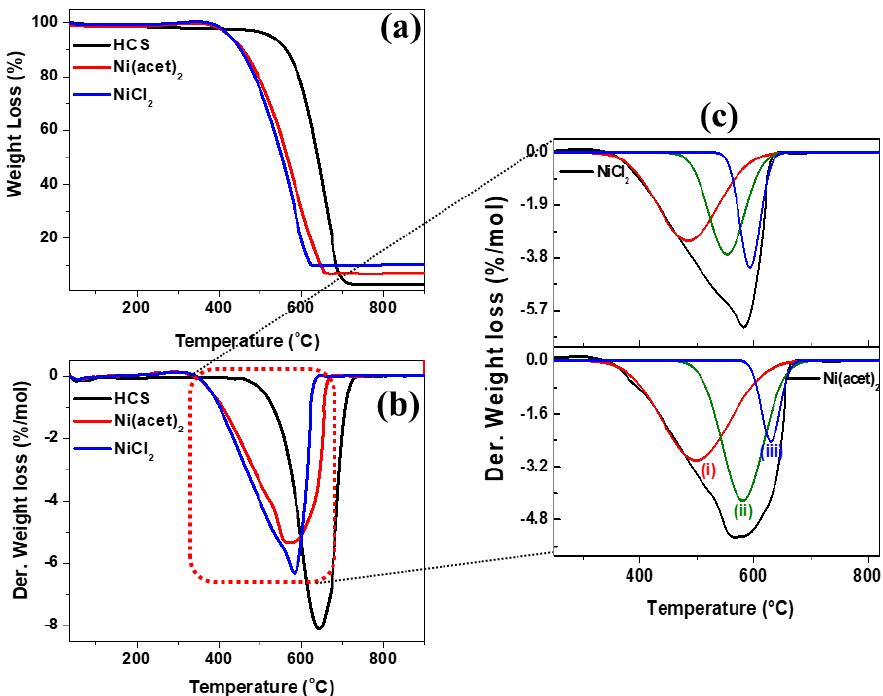
Figure 4: ( a ) TGA plots and ( b ) DTG profiles of pristine HCSs and Ni@HCSs samples, ( c ) deconvo- luted derivative plots of the Ni@HCSs nanocatalysts.